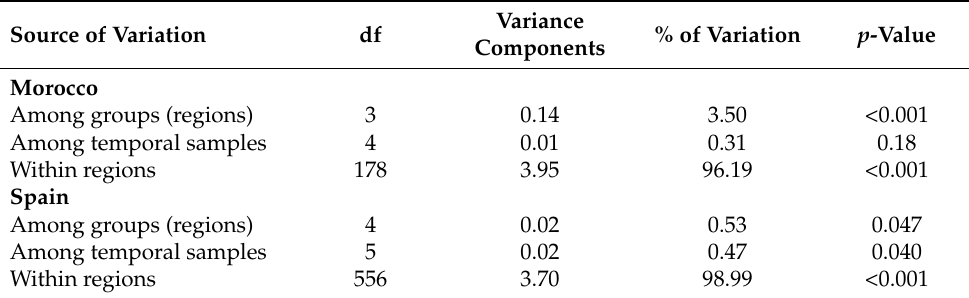
Table 4. Global hierarchical analysis of molecular variance (AMOVA) testing for temporal variation in the population structure of Dupont’s lark in Morocco and Spain. Source of Variation df